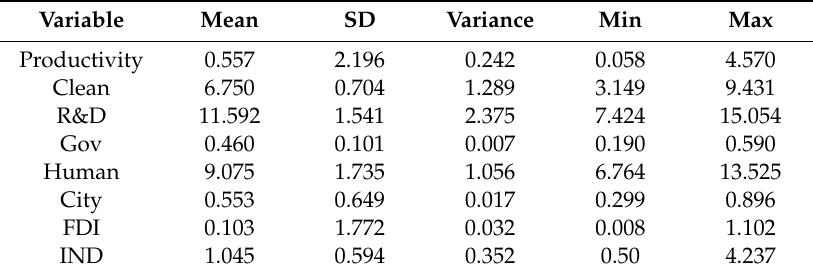
Table 1. Descriptive statistics of variables.